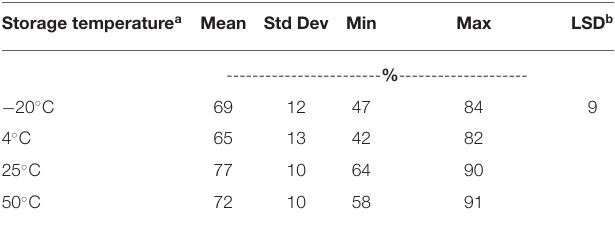
TABLE 2 | Germination capacity of Echinochloa colona from Arkansas, averaged across accessions, after storage at various temperatures for 7 d, Altheimer